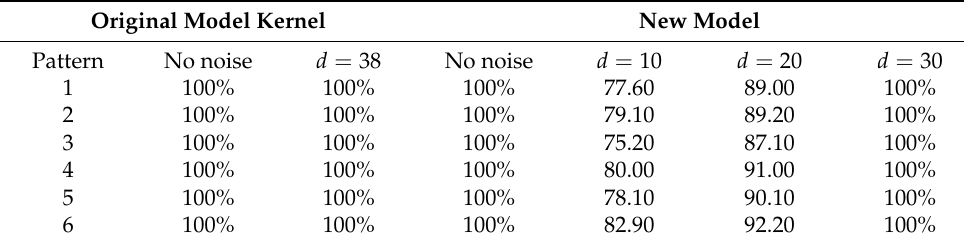
Table 8. Performance of the proposed model vs. original model in 80 × 80 grayscale images.